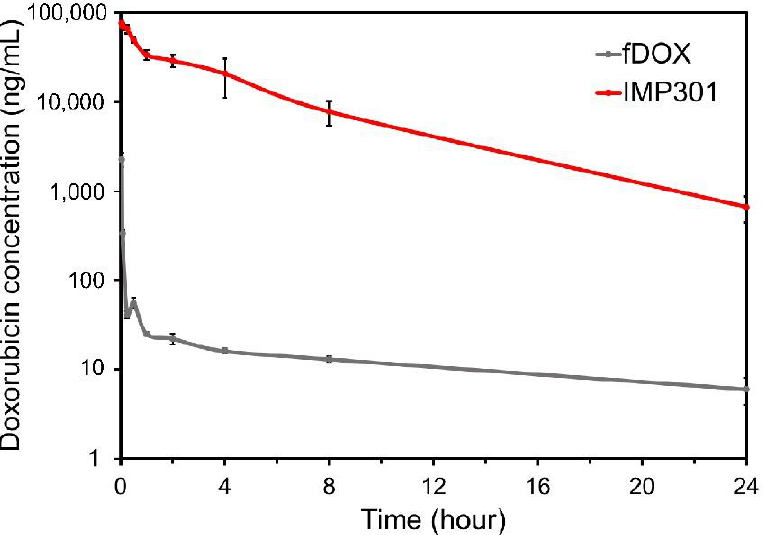
Figure 6. Pharmacokinetic profiles of free doxorubicin (fDOX) and IMP301 in the plasma. The concentrations of fDOX and IMP301 are indicated by the gray and red lines, respectively.